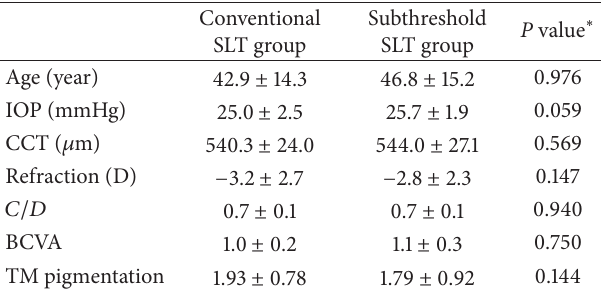
Table 1: Pretreatment patient